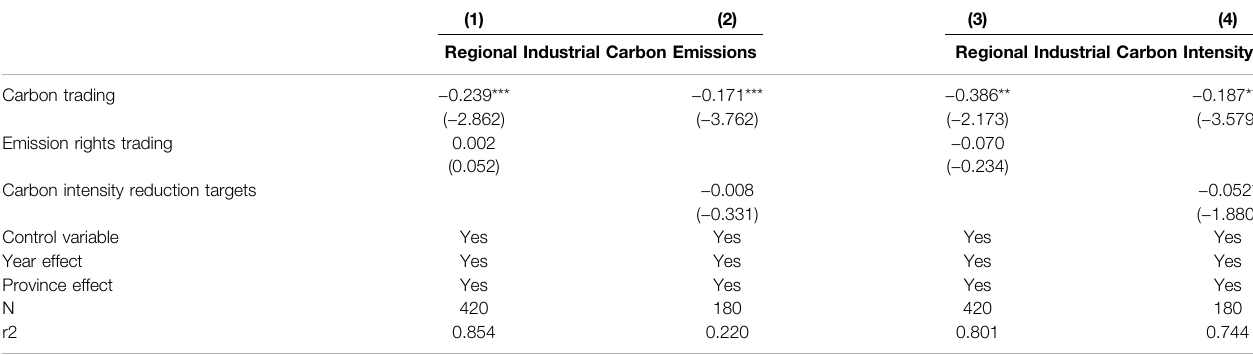
TABLE 8 | Impact of carbon trading on carbon emissions excluding interference from other environmental policies.